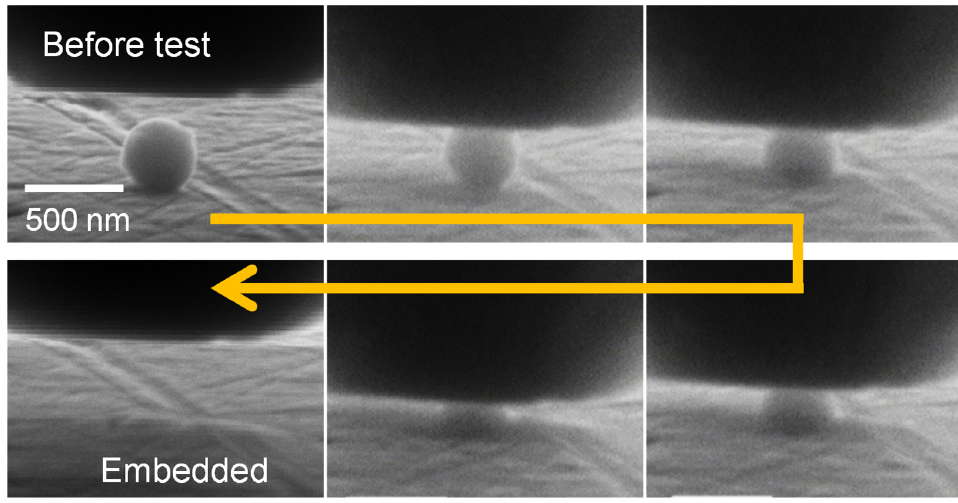
Figure 7. Embedment process of TiC SMPs on an Al substrate.